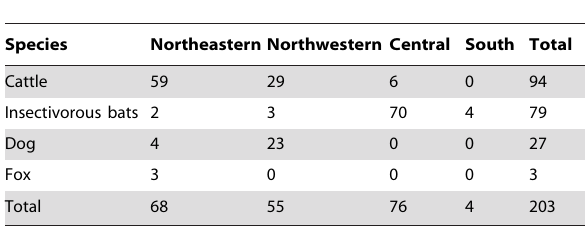
Table 1. Regional distribution of rabies in Argentina, 2008–